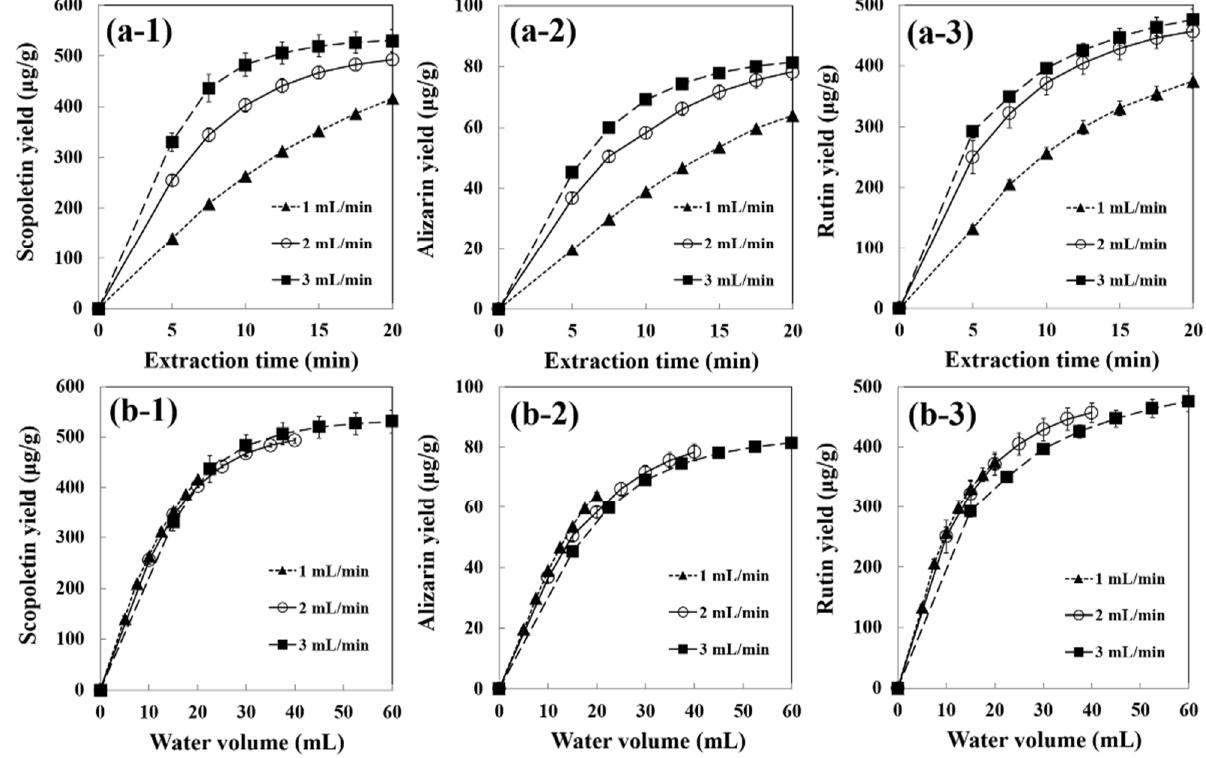
Figure 3. Effect of water flow rate ( a ) and water volume ( b ) on cumulative yields of scopoletin ( a1 , b1 ) at 140 °C, alizarin ( a2 , b2 ) at 140 °C, and rutin ( a3 , b3 ) at 120 °C from noni fruits extracted by SWE. Data are mean ± SD ( n = 3).